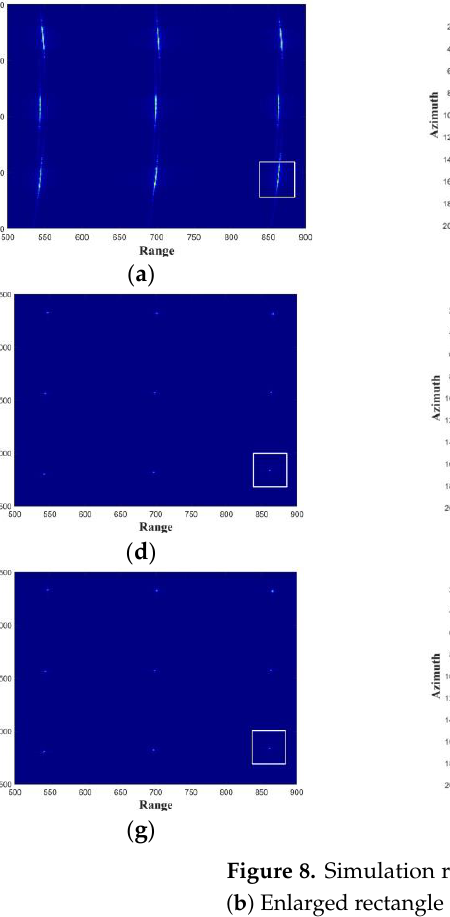
Figure 7. Motion displacements in the Cartesian coordinate system.